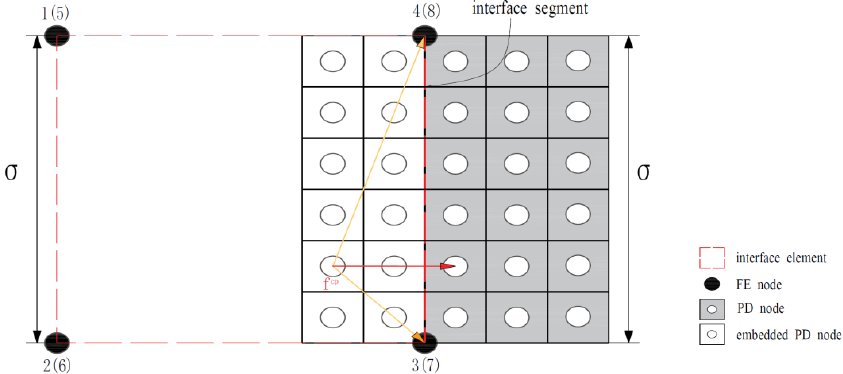
Figure 2. coupling scheme that divides a coupling force f p to FEM nodes on the interface segment. Figure 2. Coupling scheme that divides a coupling force f